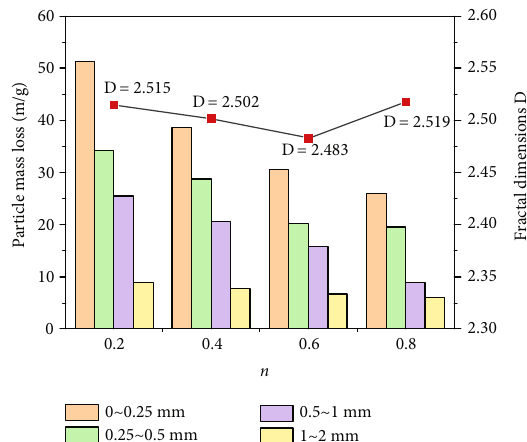
Figure 5: Fractal characteristics of grain loss.